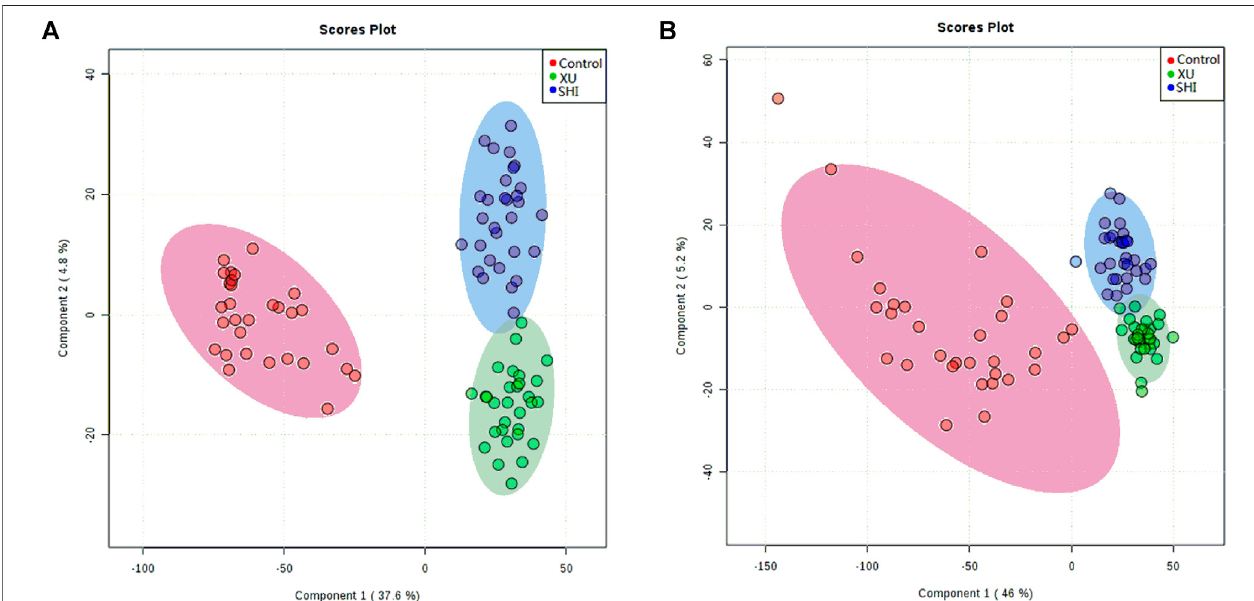
FIGURE2| PLS-DAscoreplotsshowingcontrolsamples(reddots, n (cid:2) 30),Shi-subtypesamples(bluedots, n (cid:2) 30)andXu-subtype samples(green dots, n (cid:2) 30) in ESI positive (A) and ESI negative modes (B)